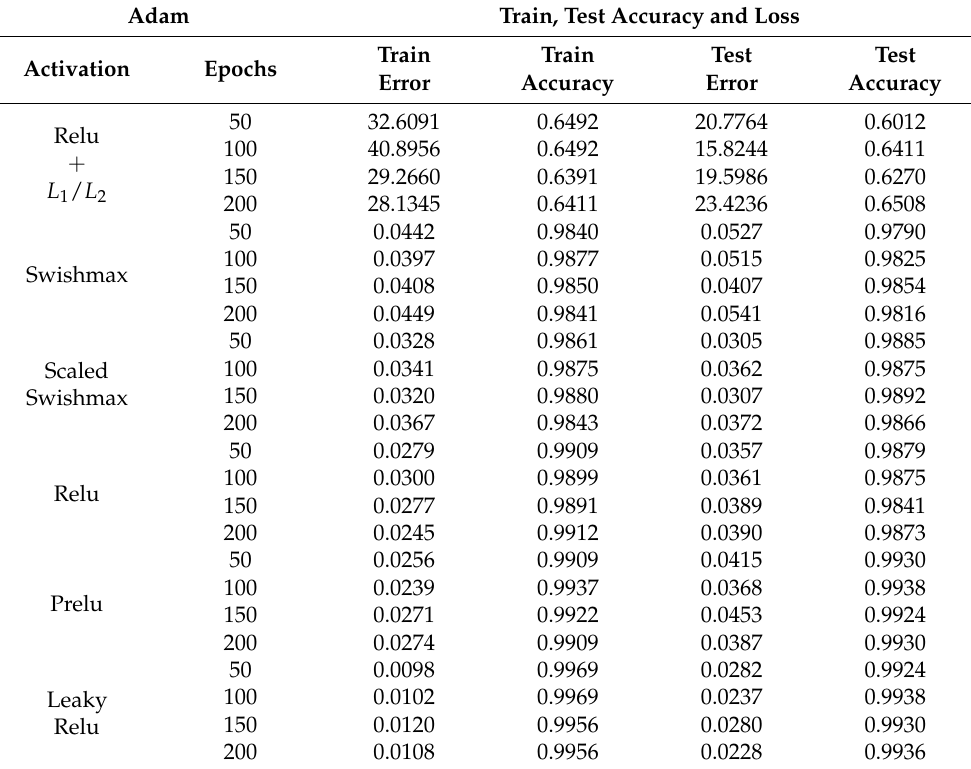
Table 3. The comparisons of the training error and accuracy and test error and accuracy in relation with varying epoch